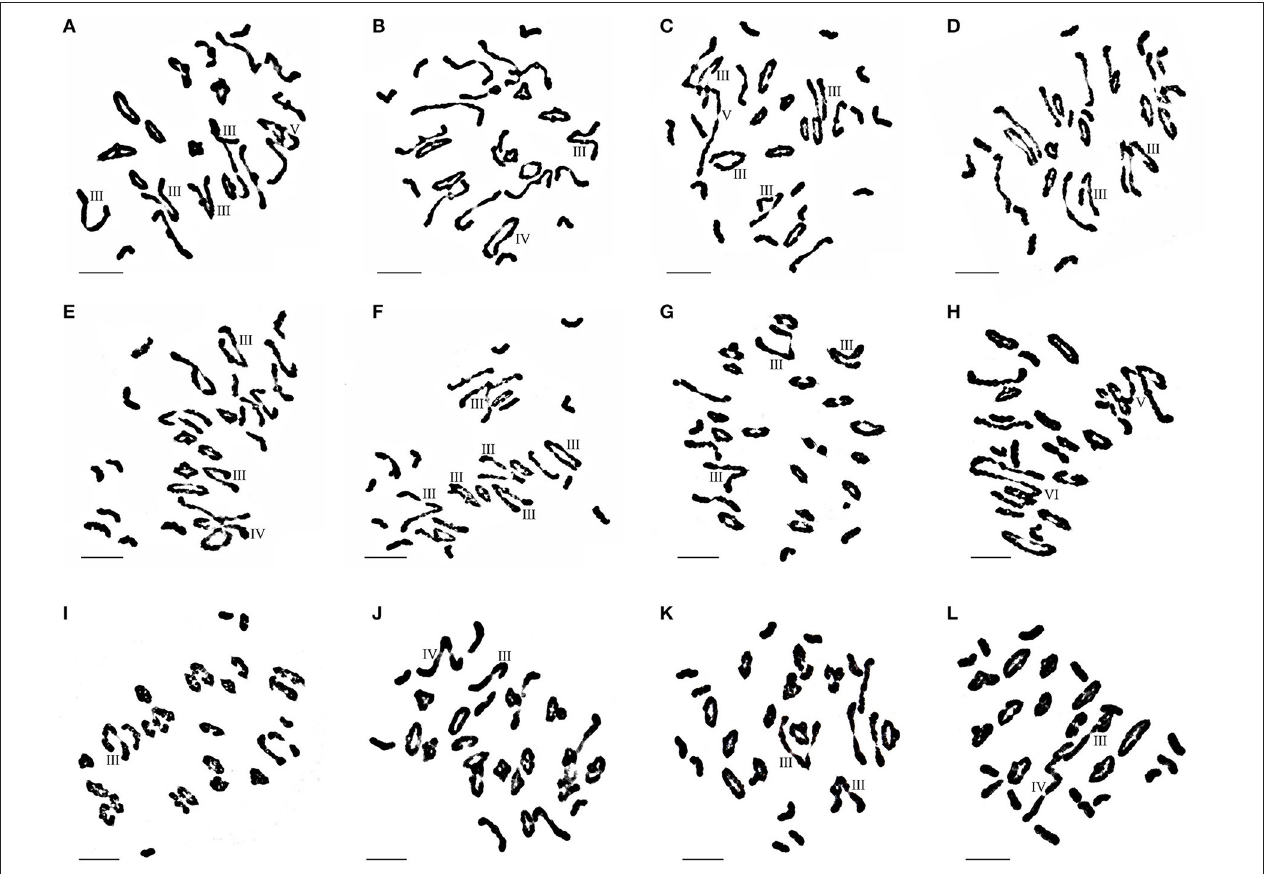
FIGURE 4 | Chromosome configuration of wheat- E. elongata BC 1 F 1 , BC 1 F 2 and BC 2 F 1 hybrids. (A–F) Chromosome configurations in BC 1 F 1 (A ) 2 n = 3I + 15II + 4III + 1IV; (B) 2 n = 6I + 17II + 1III + 1IV; (C) 2 n = 12I + 10II + 4III + 1V; (D) 2 n = 8I + 16II + 2III; (E) 2 n = 11I + 12II + 2III + 1IV; (F) 2n = 10I + 9II + 6III; (G–J) Chromosome configurations in BC 1 F 2 (G) 2 n = 3I + 19II + 3III; (H) 2 n = 5I + 14II + 1V + 1VI; (I) 2 n = 7I + 21II + 1III; (J) 2 n = 3I + 20II + 1III + 1IV; (K–L) Chromosome configurations in BC 2 F 1 (K) 2 n = 10I + 13II + 2III; (L) 2 n = 15I + 11II + 1III + 1IV. Bar = 10 µ